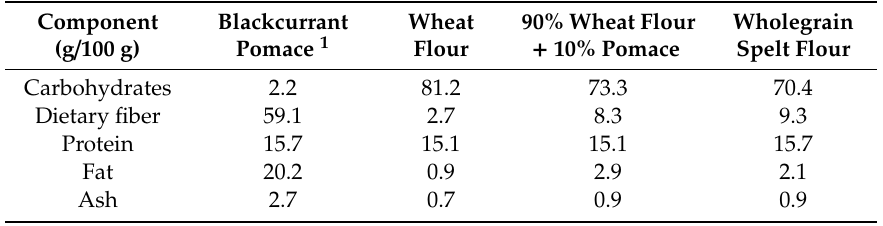
Table 1. Dry matter-based proximate composition of raw